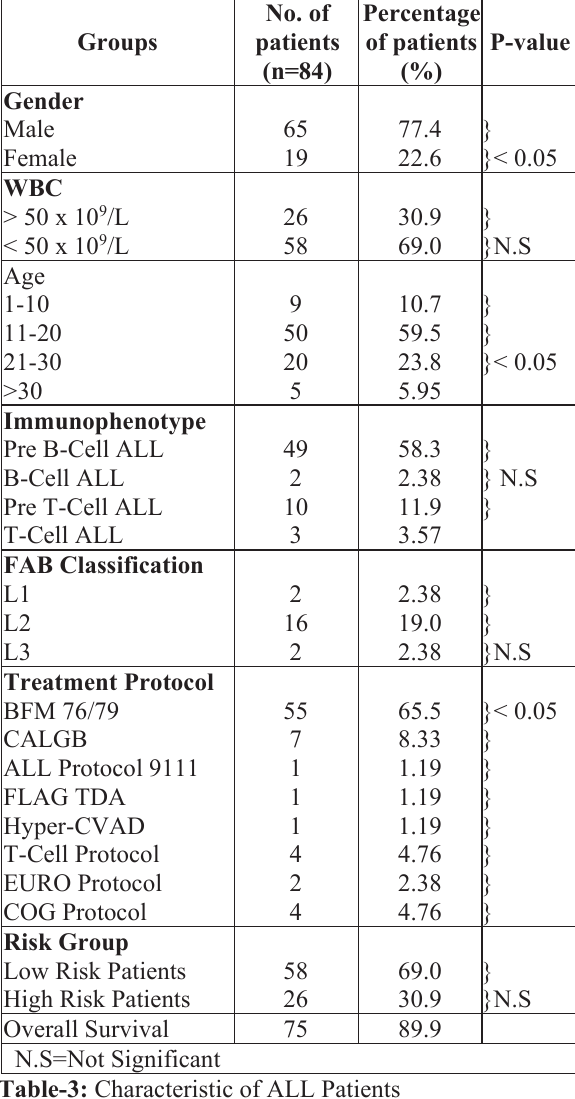
Table-3: Characteristic of ALL Patients